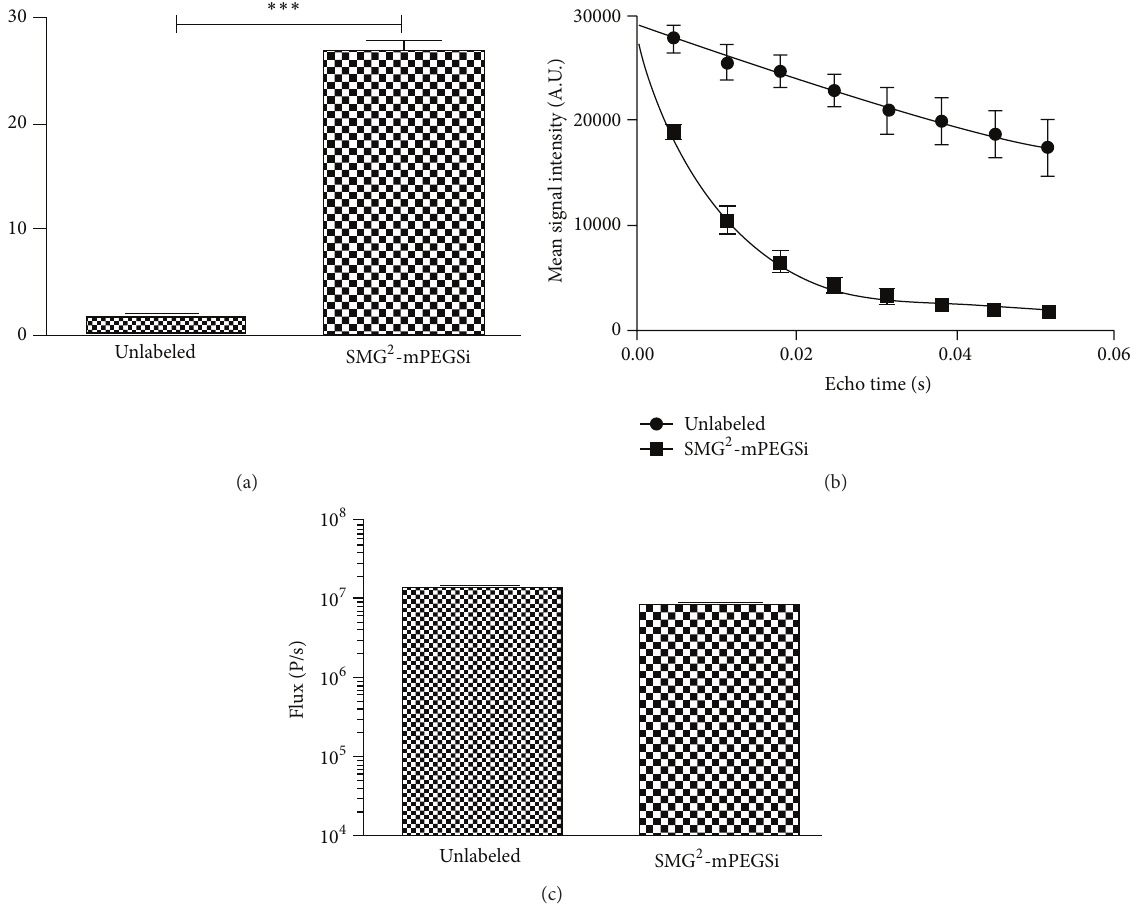
Figure 3: In vitro validation of SPIO labeling of hMultistem cells. (a) ICP-OES experiments confirmed iron internalization after SPIO labeling ( 10 ± 1 pg Fe cell −1 ) but not for unlabeled control cells. (b) Multiecho T 2 map (MRI) confirms higher relaxation rats for SPIO labeled cells compared to controls. (c) BLI signal intensity was not significantly affected by SPIO labeling of cells ( ∗∗∗ 𝑝 < 0.001 ).